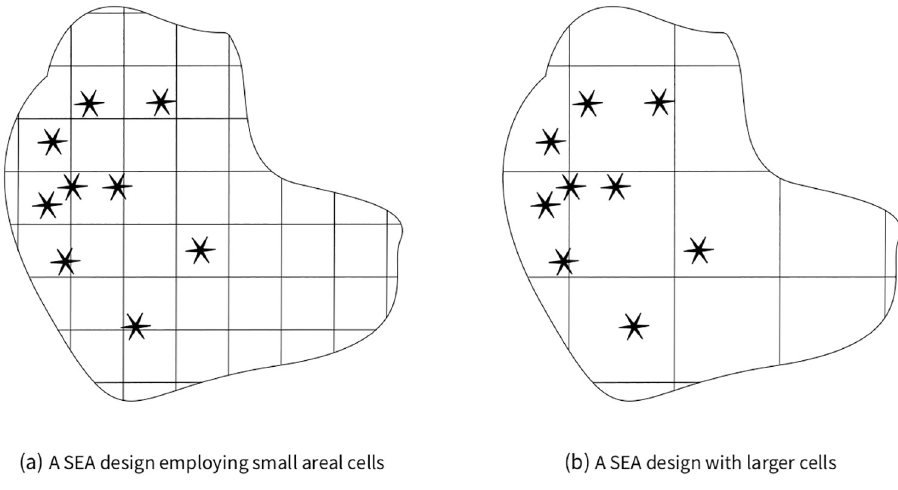
Fig 2. Illustration of the consequences of varying cell sizes. On the left, smaller cells capture local variation in causes of violence. On the right, larger cells overaggregate events. Also note the difference is the numbers of cells available for the regression